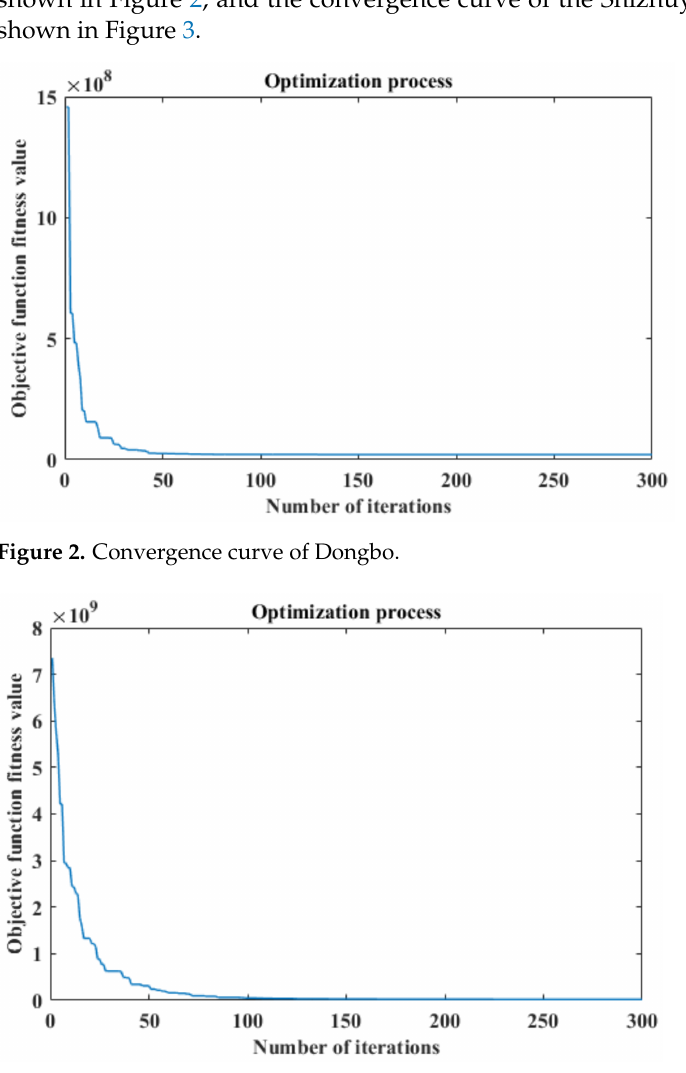
Figure 3. Convergence curve of Shizhuyuan.